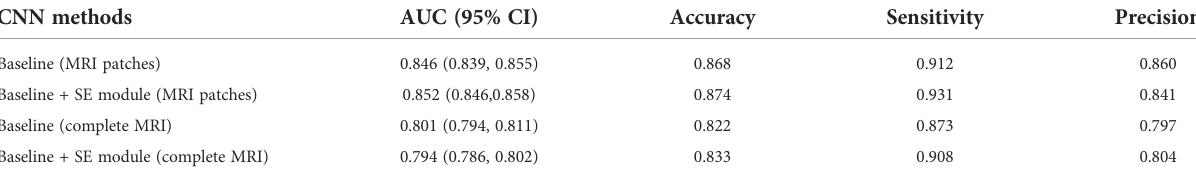
TABLE 2 The experimental results of grading using CNN methods.